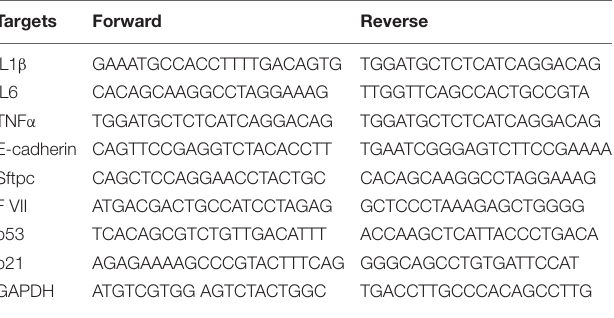
TABLE 1 | Primer sequences for reverse transcription quantitative polymerase chain